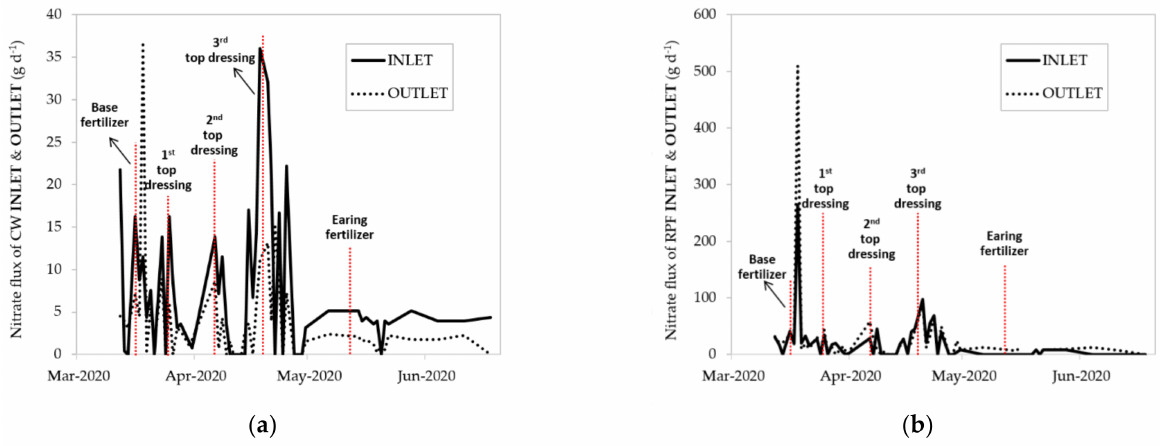
Figure 5. Nitrate fluxes of INLET and OUTLET in ( a ) CW treatment and ( b ) RPF treatment of the first crop season, 2020 (March–June); each fertilization timing is marked. Table 5. The average nitrate fluxes and removal efficiency of each fertilization period. Fertilization